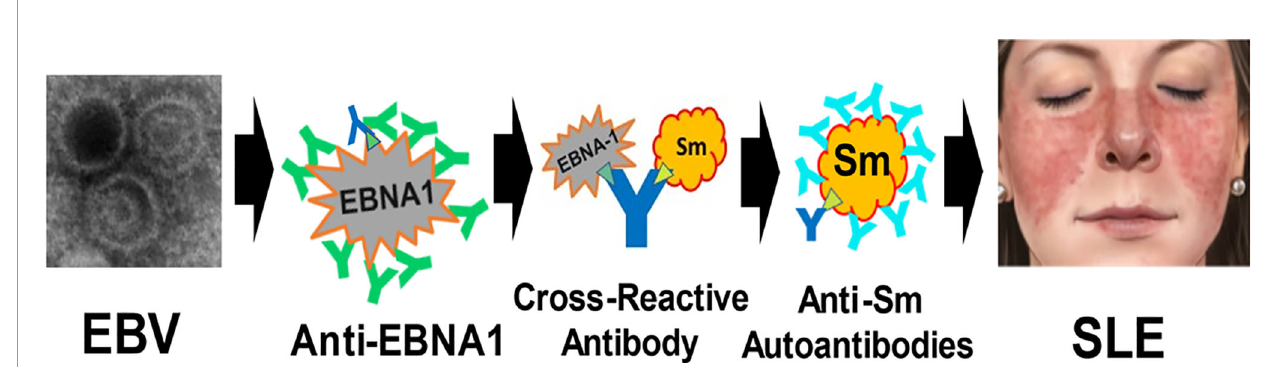
FIGURE 1 | Model for the generation of systemic lupus erythematosus (SLE) by Epstein – Barr virus (EBV). After infection, EBV establishes a lifelong infection sustained by EBV in latency usually expressing at least Epstein – Barr nuclear antigen 1 (EBNA1). Anti-EBNA1 antibodies are produced in response to the EBV infection (green and dark blue Y ). Eventually, one or more cross-reacting antibodies form (dark blue Y) , binding both EBNA1 and lupus autoantigens (e.g., Sm B/B ’ ) at structures that are antigenically similar (green triangle). This is the molecular mimicry step with heteroimmune antibodies making the transition to autoimmunity. Then, B-cell epitope spreading leads to a mature complex autoantibody (lighter blue Y ) response, inducing the in fl ammatory changes that culminate in the systemic disease manifestations of SLE. The speci fi c role of EBV transcription cofactors [e.g., EBNA2, not shown (22)] and other contributing components in this model of SLE pathogenesis remains to be de fi ned. (The EBV image, courtesy: National Institute of Allergy and Infectious Diseases. The SLE malar rash image, courtesy: Mayo Foundation, all rights